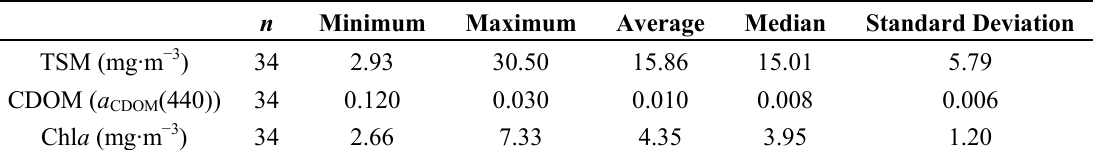
Table 4. Descriptive statistics of TSM, CDOM and chl a measurements used in Lake Balaton UFL field measurement calibration and validation.